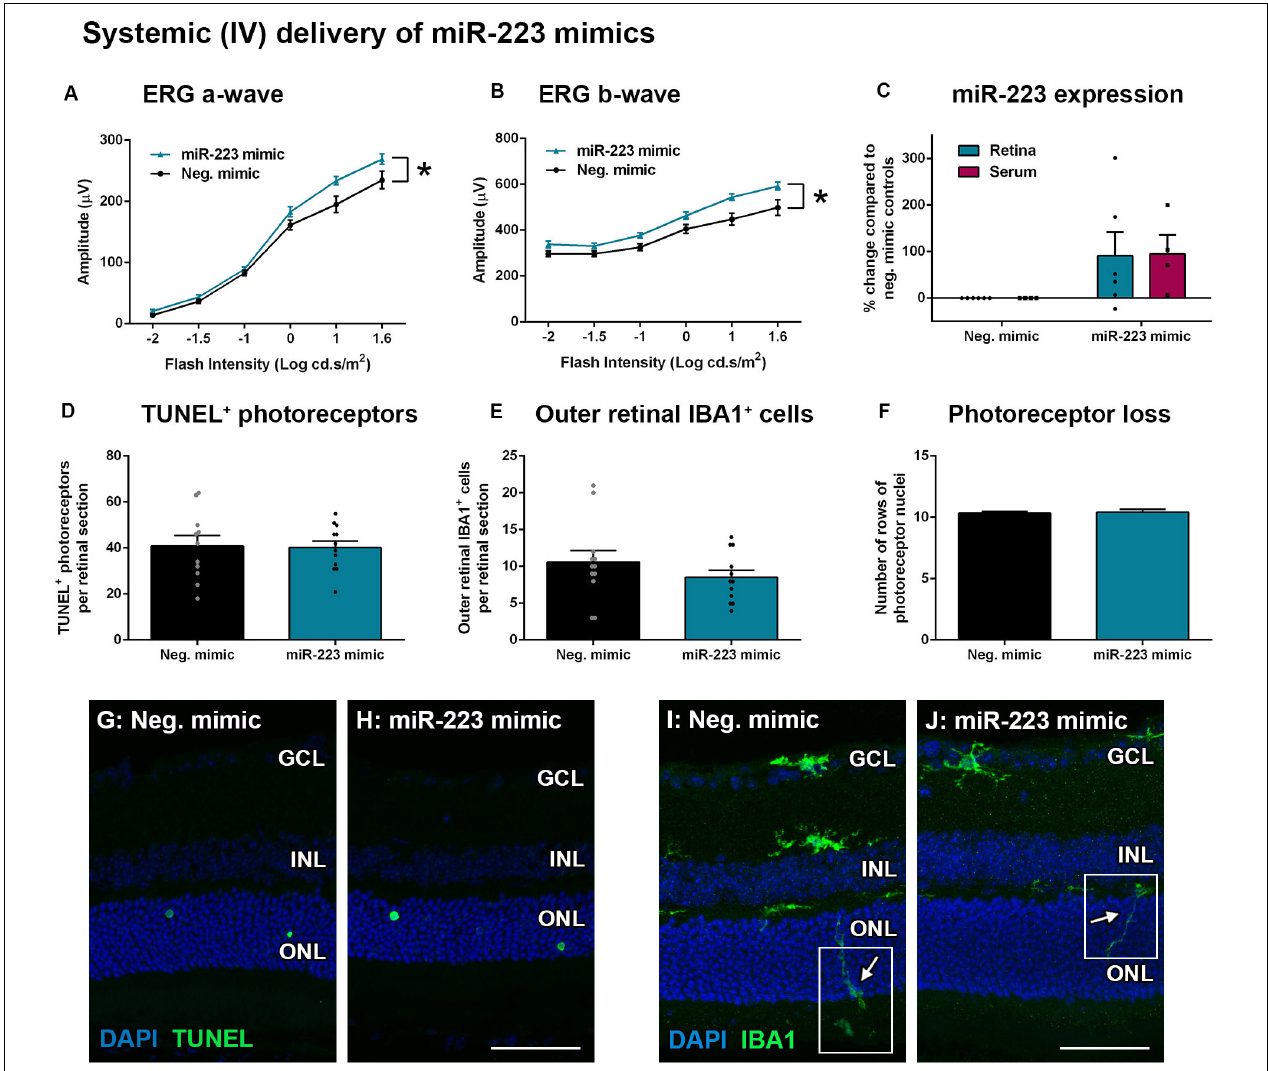
FIGURE 6 | Systemic intravenous (IV) delivery of miR-223 mimics during 5 days of photo-oxidative damage. (A,B) WT animals injected with miR-223 mimics again had a significantly higher a-wave (A) and b-wave (B) than negative controls ( P < 0.05), as assessed by electroretinography (ERG). (C) Retinal and serum expression of miR-223 were not significantly changed after miR-223 mimic injections ( P > 0.05). (D,E) There was no significant difference in TUNEL + (D) or IBA1 + cells in the outer retina (E) between groups ( P > 0.05). (F) No change in photoreceptor cell rows was observed between groups ( P > 0.05). (G,H) Representative images depicting TUNEL + photoreceptors (green). (I,J) Representative images depicting IBA1 immunohistochemistry (green), with arrows pointing toward the processes of IBA1 + cells in the outer retina (white boxes). GCL, ganglion cell layer; INL, inner nuclear layer; ONL, outer nuclear layer. Scale bar is 50 µ m. Sample size is N = 4–6. *Denotes significance ( P <